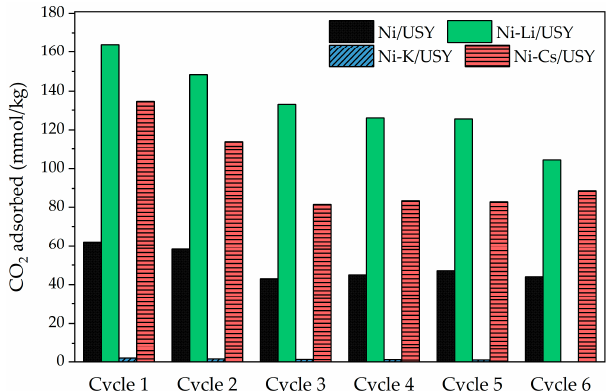
Figure 2. CO 2 adsorption capacity of Ni/USY and Ni-A/USY catalysts under cyclic experiments. Adsorption was performed at 150 ◦ C (CO 2 /N 2 ; 60 min) and desorption at 450 ◦ C (N 2 ; 10 min).